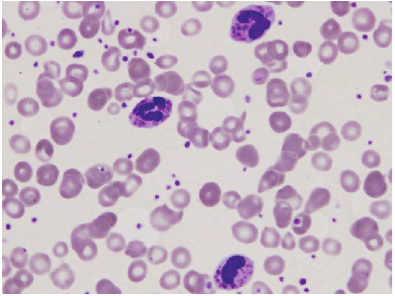
Figure 2: Peripheral blood smear of our patient with Chediak- Higashi depicting three polymorphonucelar leucocytes with inclu- sion bodies. These findings are typical in Chediak-Higashi syn- drome.